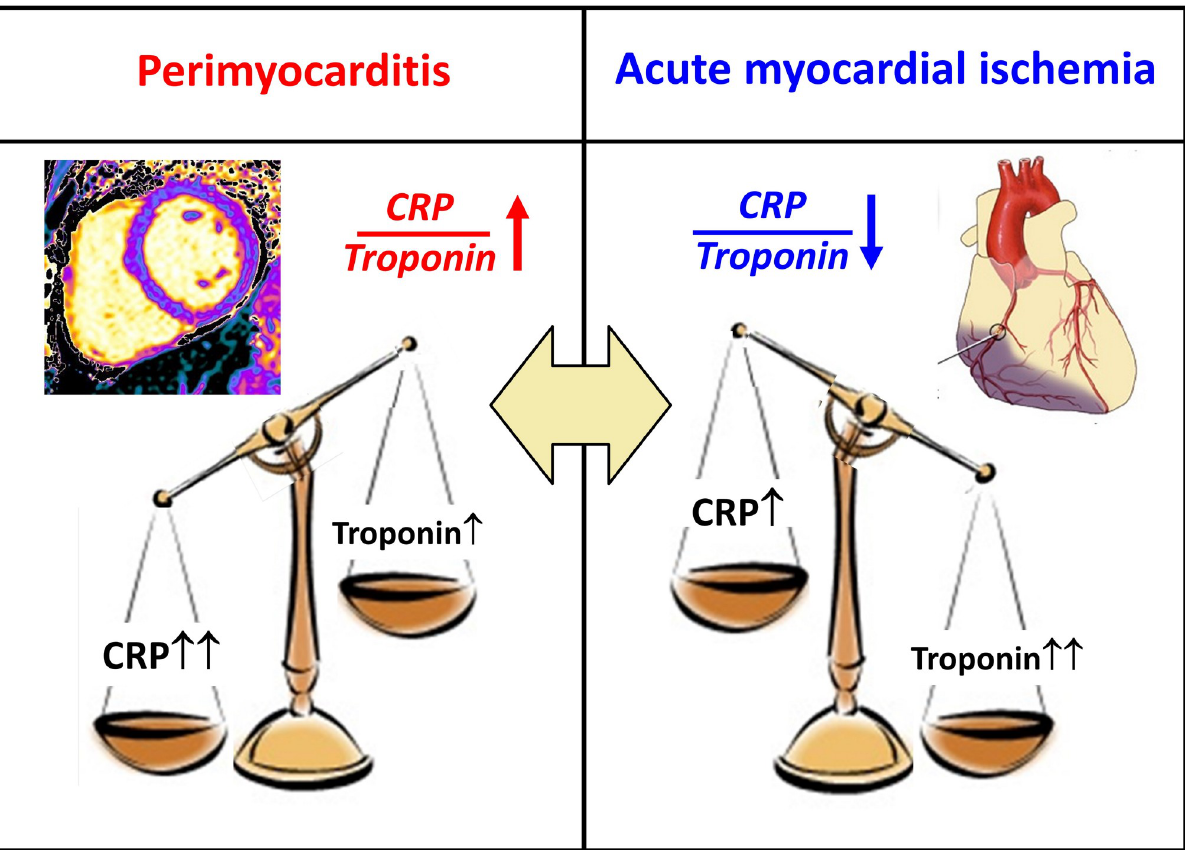
Fig 1. Central figure showing study rationale. The primary pathologic process in myopericarditis is inflammation associated with high CRP and relatively low-range but higher than normal troponin concentrations, while myocardial infarction is characterized by elevated troponin with a relatively lower increase in CRP levels. The CRP/troponin biomarker will amplify these